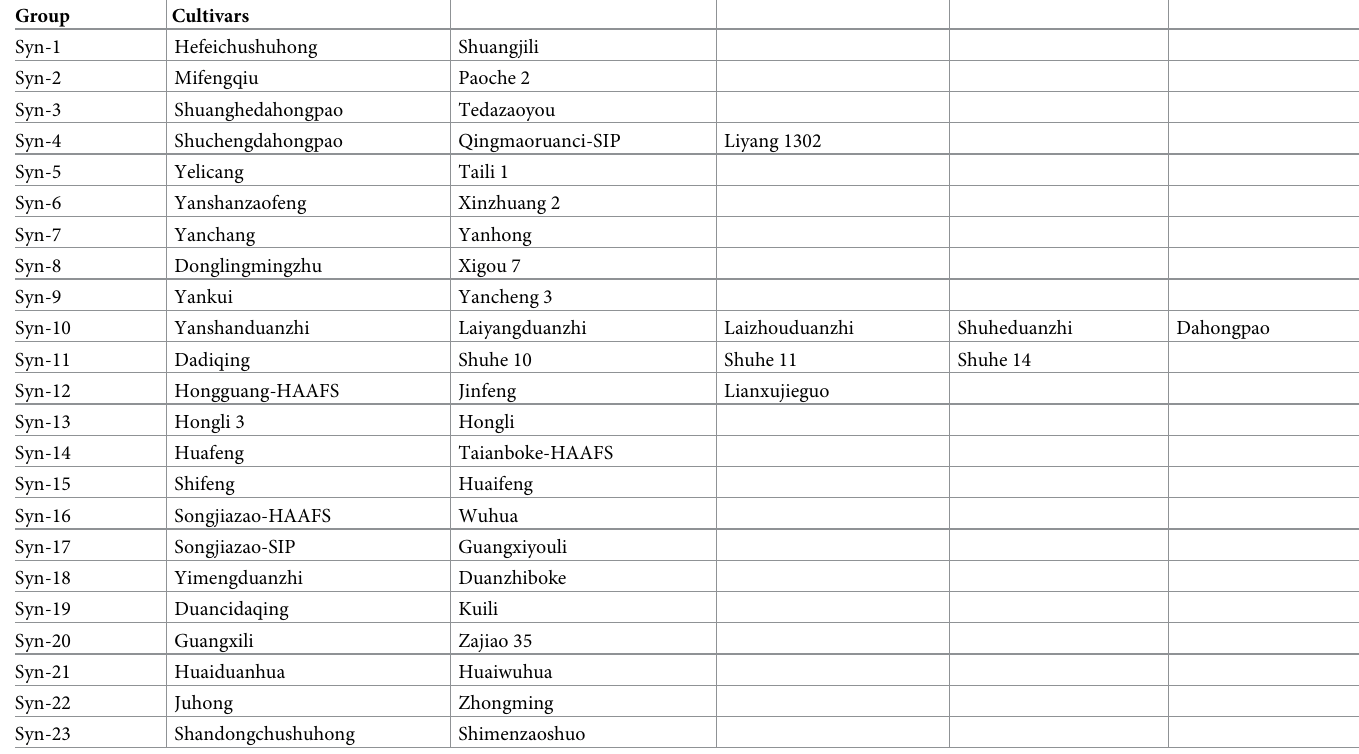
Table 2. Chinese chestnut cultivar groups with identical SSR genotypes for all 31 SSR markers.